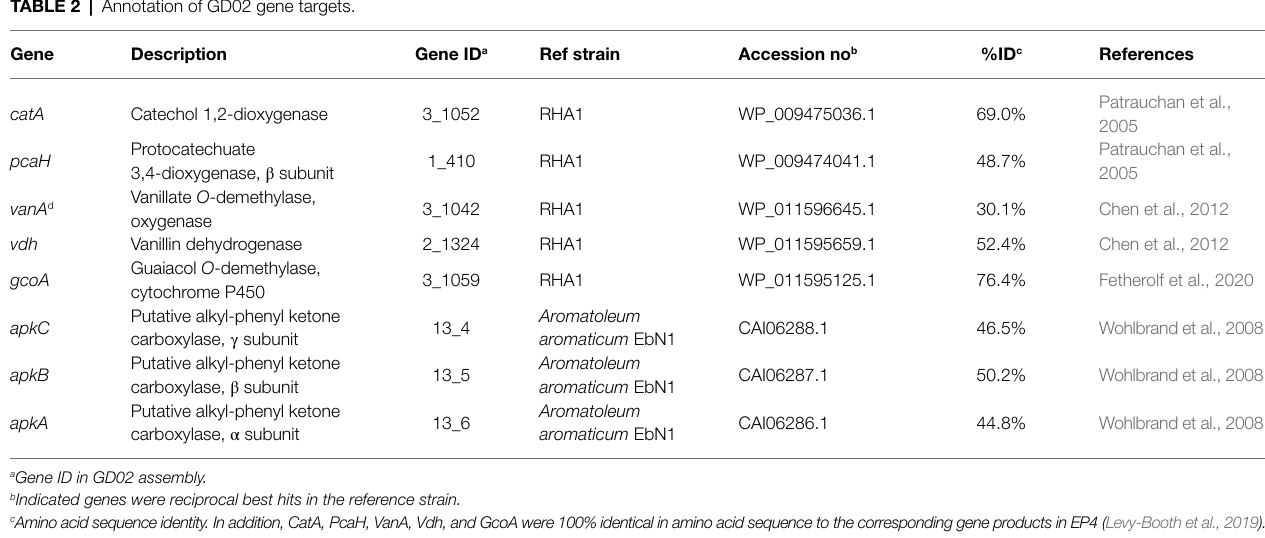
TABLE 2 | Annotation of GD02 gene